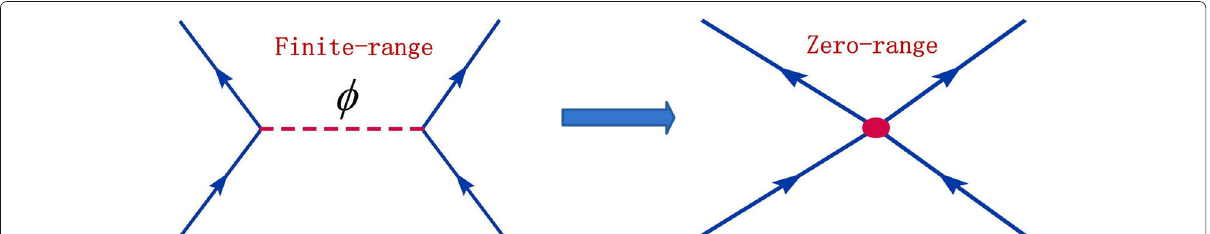
Fig. 1 Finite-range (left) and zero-range (right) nucleon–nucleon interactions employed in building the nuclear covariant density functional